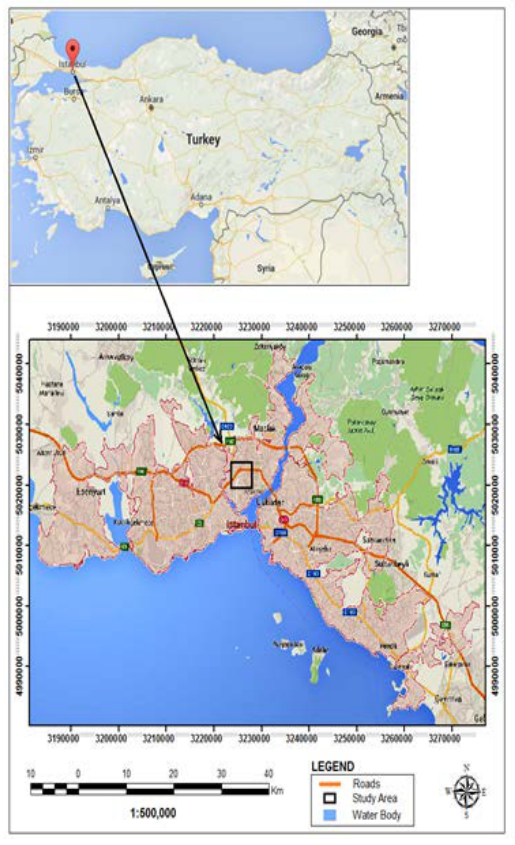
Figure 1. Map of Istanbul showingg the study